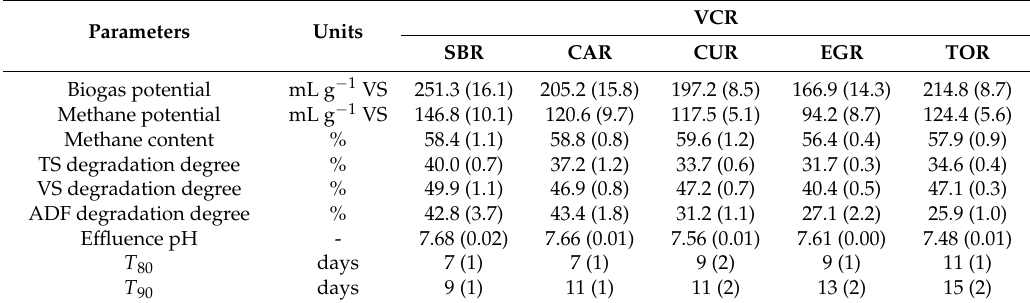
Table 2. Measured biogas and methane potential, TS, VS, and ADF degradation degree, effluence pH, and technical digestion time for different VCRs.